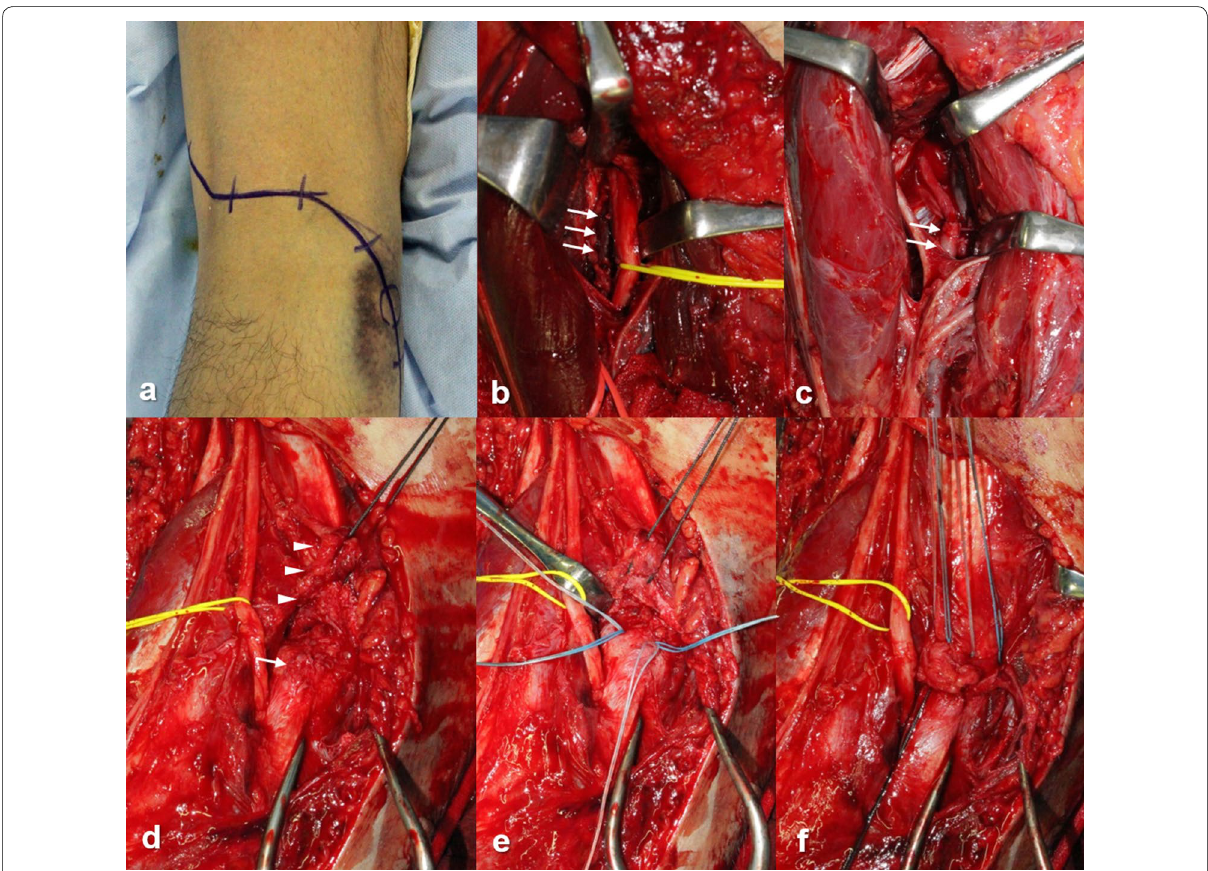
Fig. 3 Vascular surgery and primary repair of posterolateral complex of left knee (same patient as in Fig. 2). a Skin incision for posterior approach; b popliteal artery thrombosed due to intimal rupture (arrows); c reversed saphenous vein graft (arrows), d PLC (arrow heads) avulsed from fibular head (arrow); e suture anchors inserted into fibular head; and f PLC fixed by suture anchors and torn posterior capsule